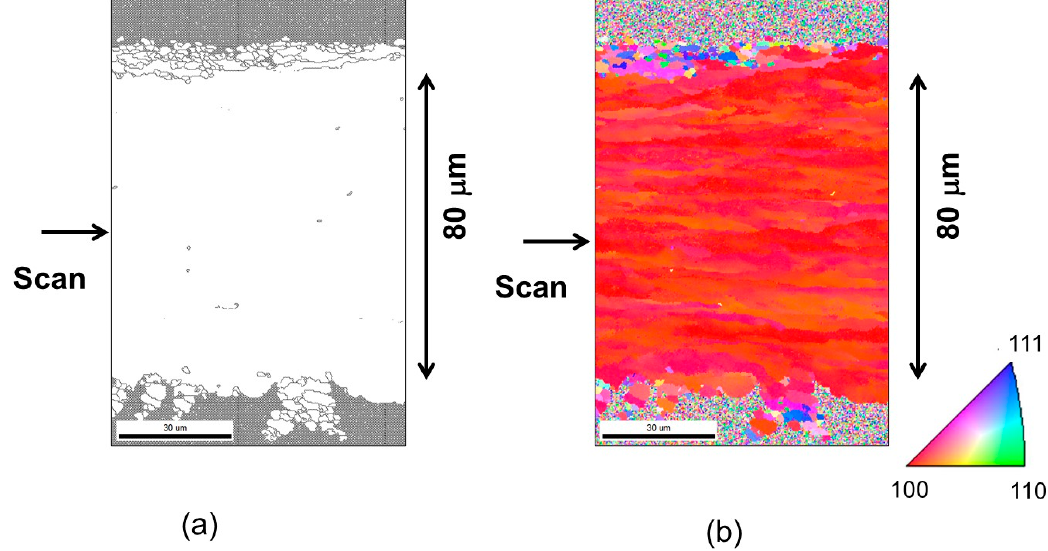
Figure 17. Global extension of the {100}-oriented grain-boundary-free film. The SiO 2 cap thickness was 123 nm, and the power was 1.4 W. ( a ) Grain boundary map, and ( b ) IPF ND map. The scan velocity was 15 mm/s. After Sasaki et al. [50].